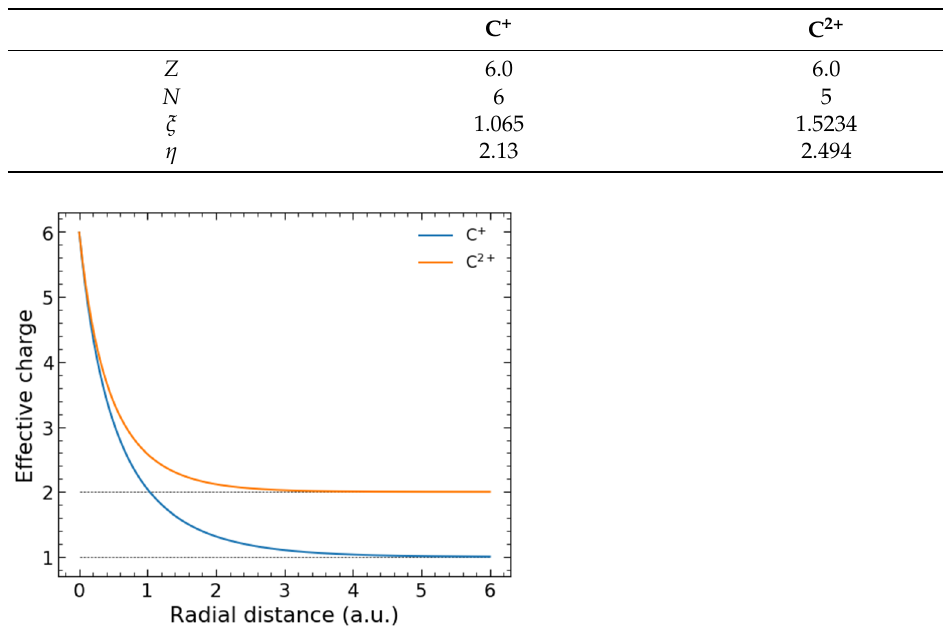
Figure 1. Garvey dynamical effective charge r V ( r ) as a function of the radial distance for the C + and C 2+ cores.